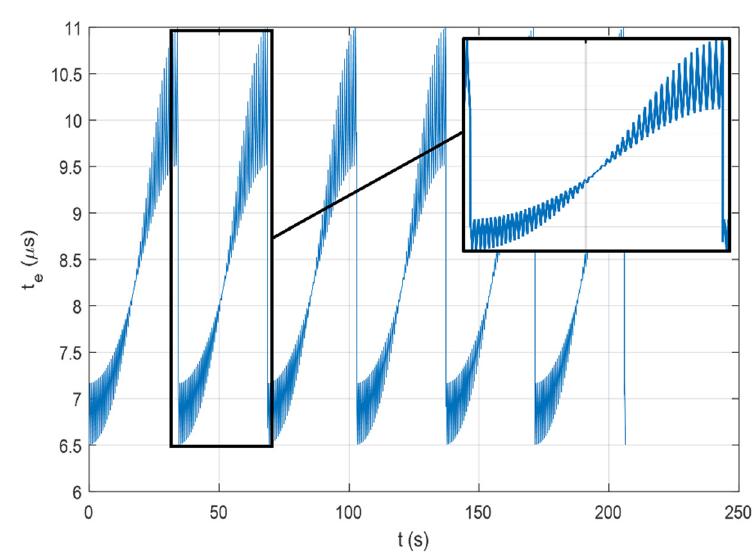
Figure 21. Dual-camera variable speed OCPSI mode: pendulum motion angular velocity.